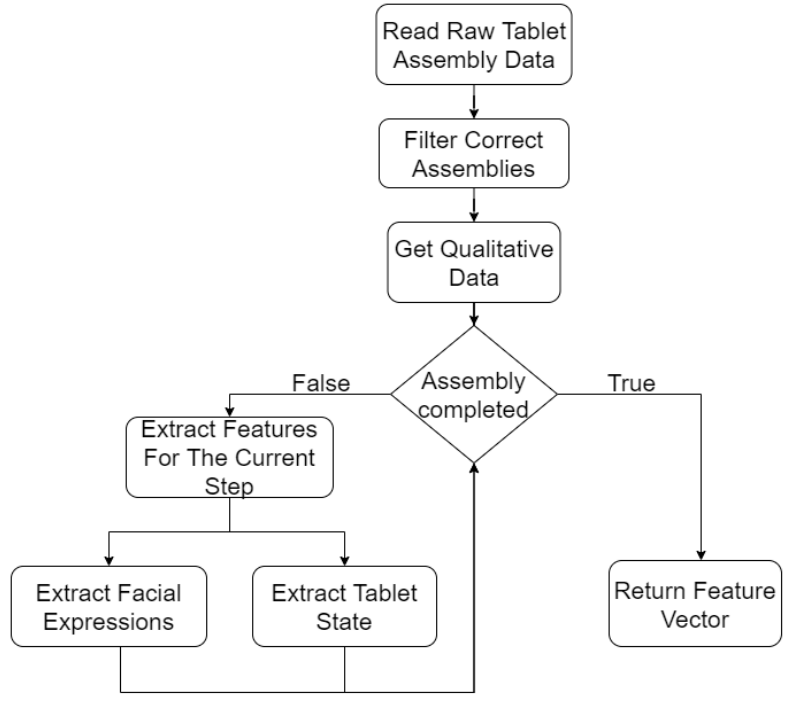
Figure 4. Feature extraction.